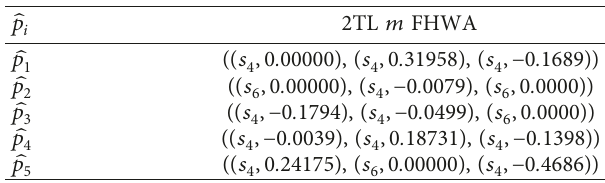
Table 6: Scores values for all the 2TL3F numbers 􏽢 p